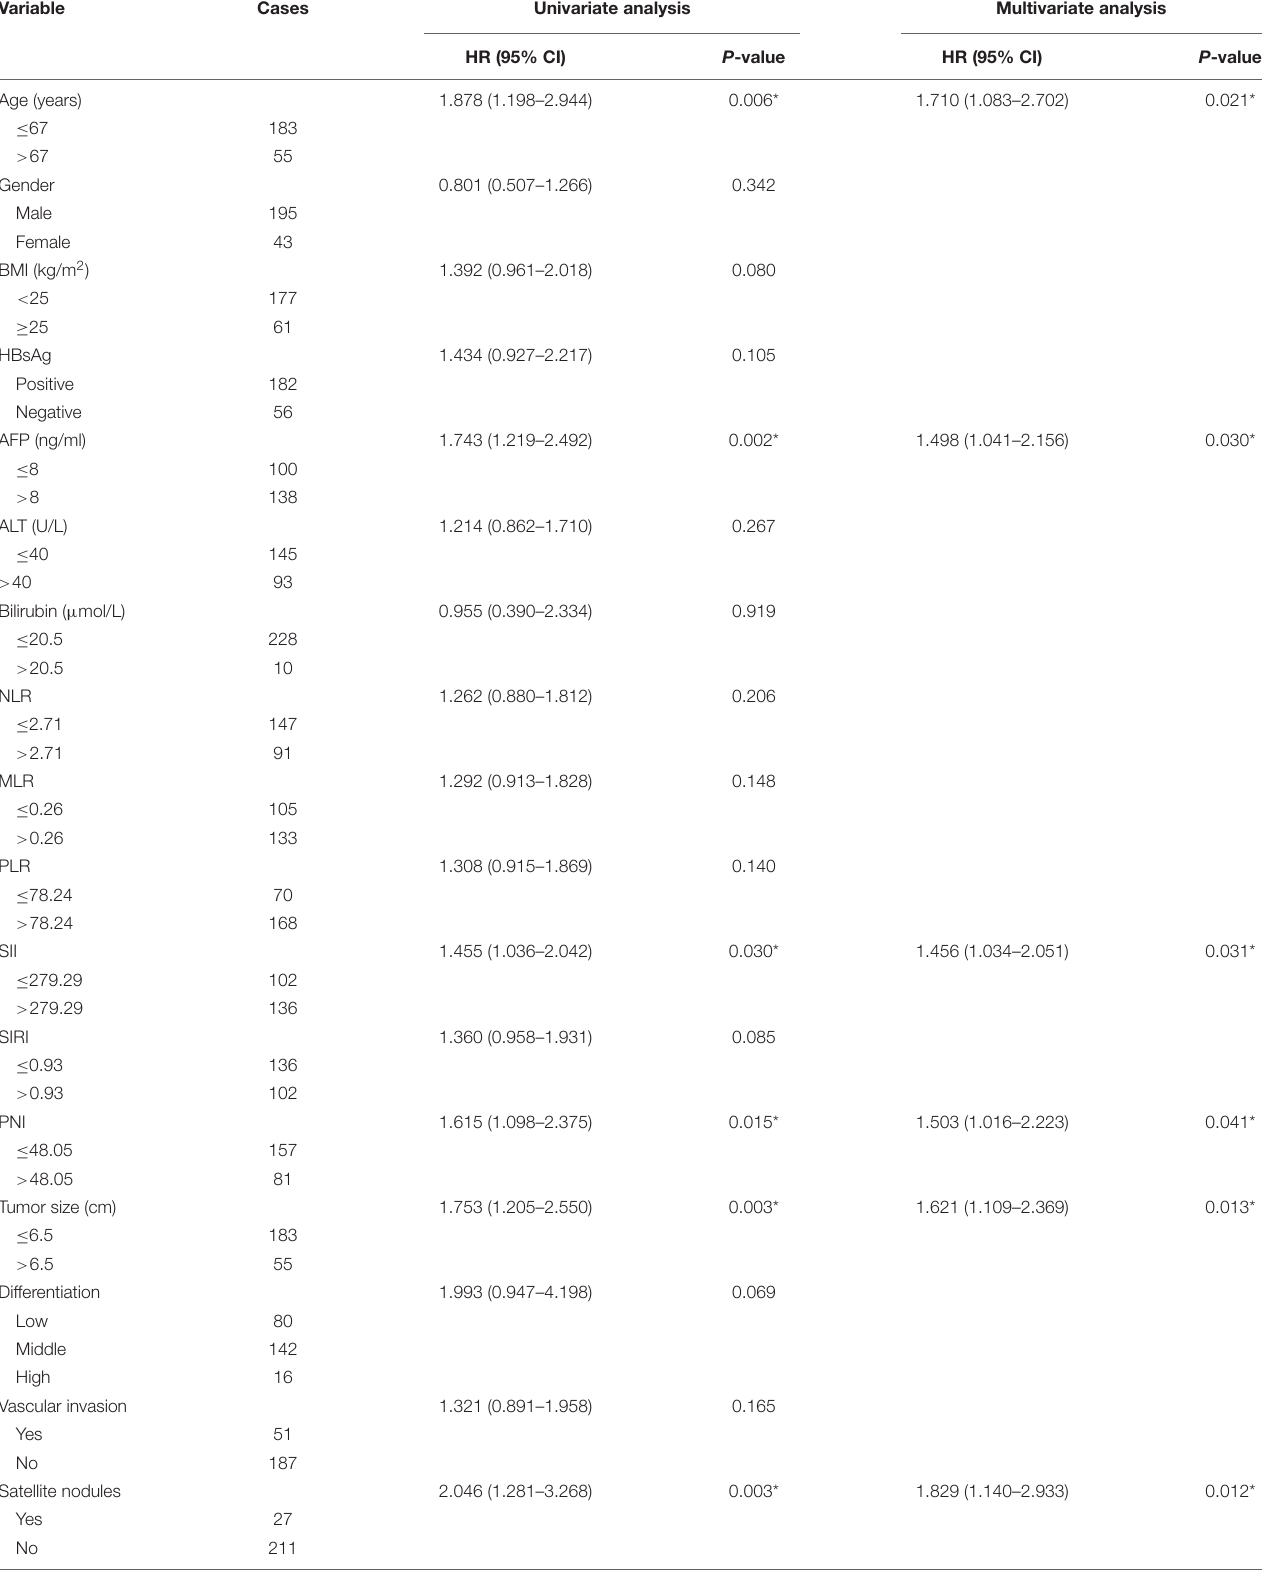
TABLE 2 | Cox proportional hazards regression analyses of recurrence in the training cohort. Variable